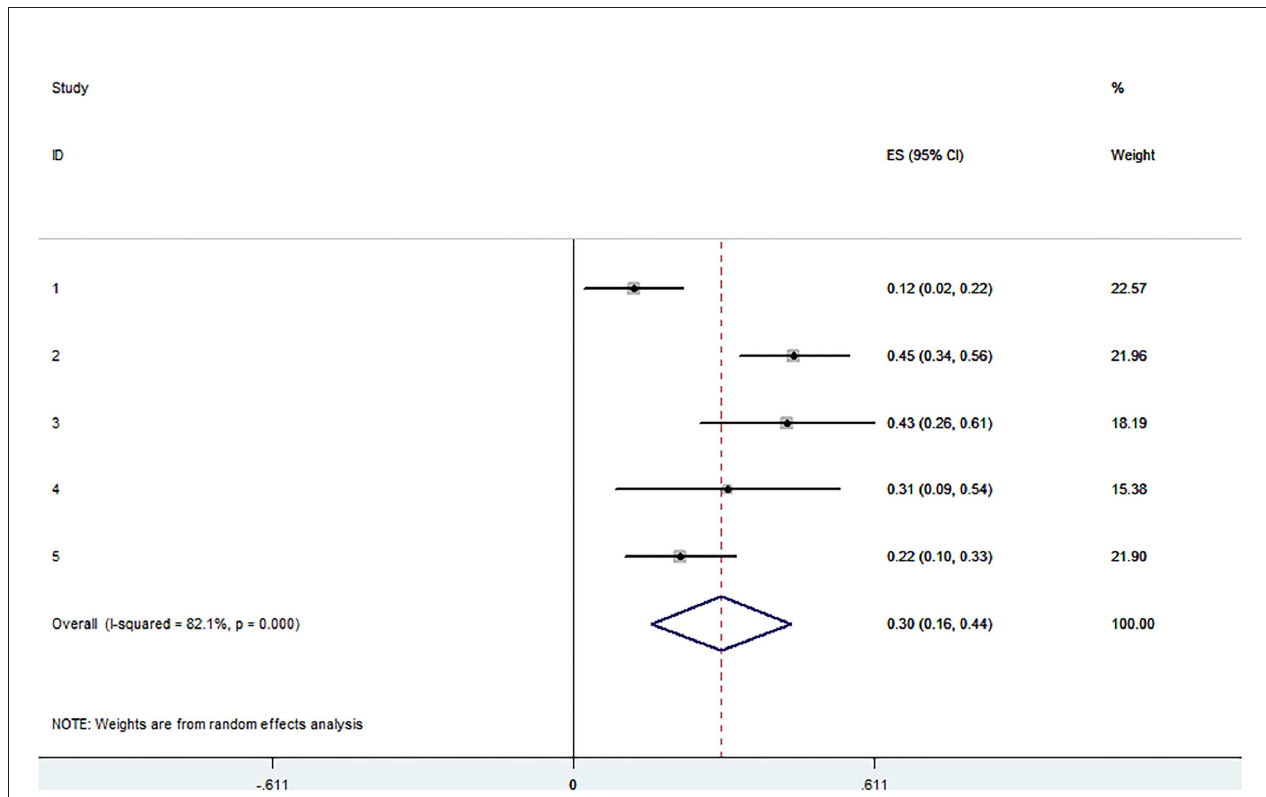
FIGURE 3 | Forest plot presenting the meta-analysis of application rate of type B. CI, Confidence intervals; ES, Effect size.